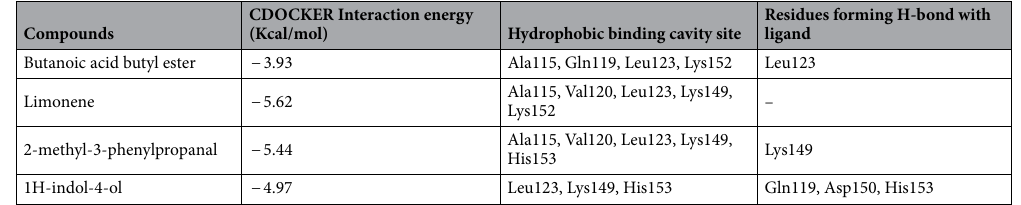
Table 3. The Docking results of MvitOBP3 against different host-plant volatile